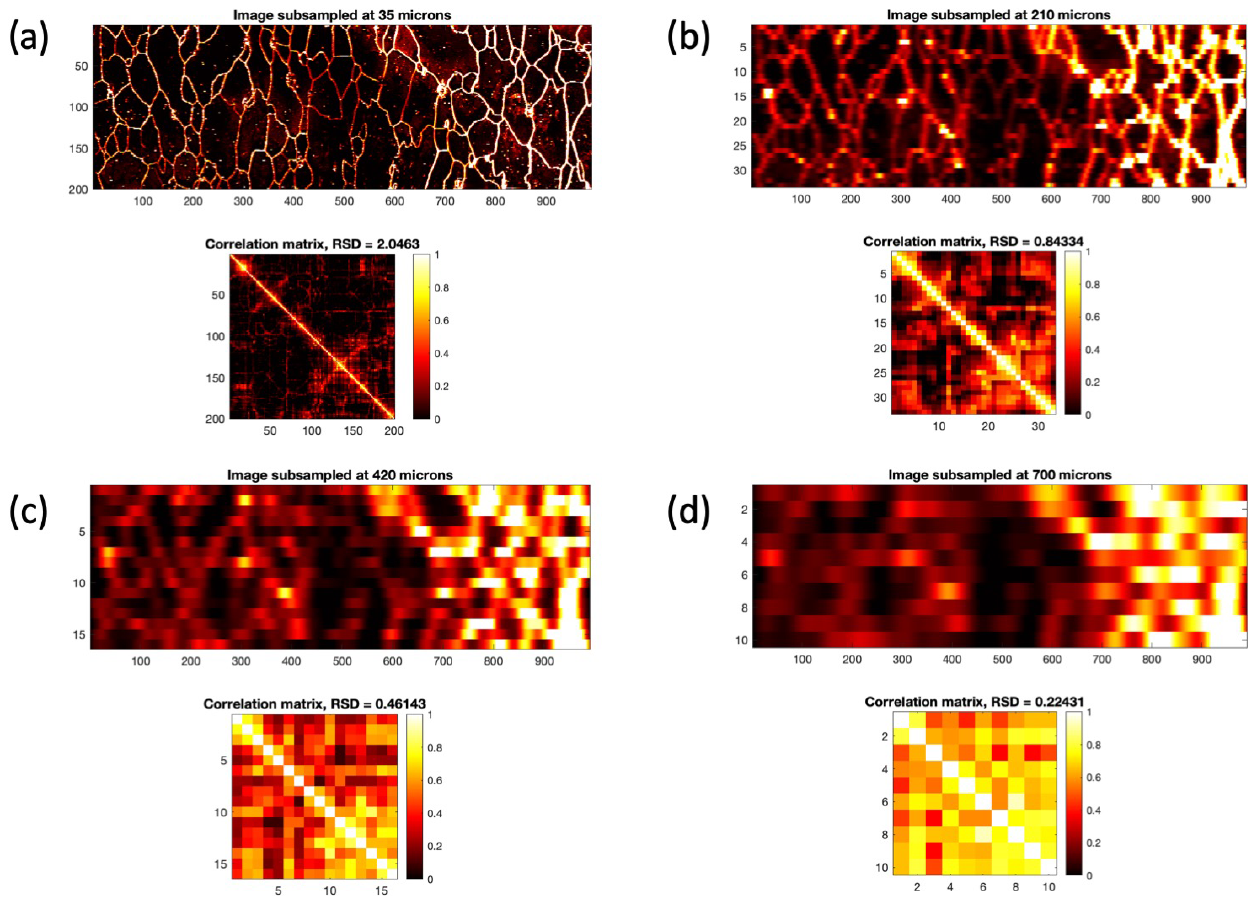
Figure 8. Same as Fig. 7 but for the EDC MIS 2